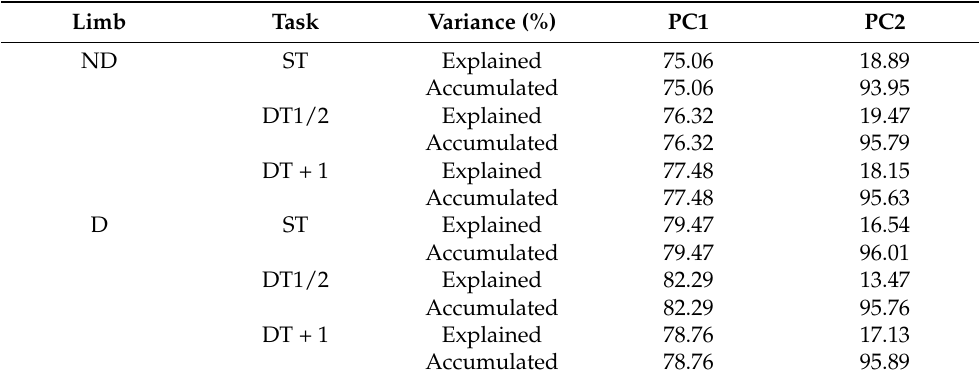
Table 1. Mean percentage of variance explained by first two principal components.